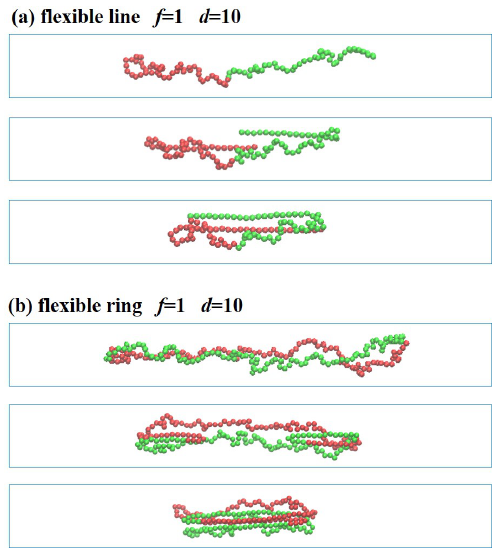
Figure 7. Compression of flexible linear and ring polymers in weak confinement d = 10 under ( a ) strong force ( f / k B T = 1.0) with the end-to-end distance L x = 43.1,31.7,24.5 and ( b ) weak force ( f / k = 1.0 ) with the end-to-end distance L x = 52.3,38.9,26.6 (from top to B T